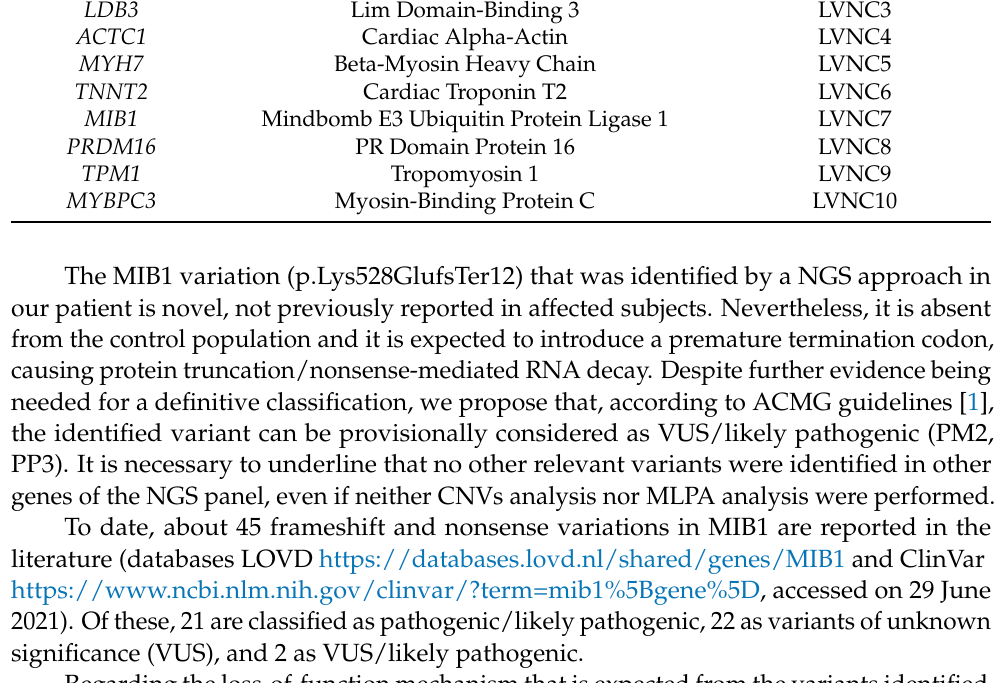
Table 1. LVNC genes according to current OMIM classification. Sarcomeric genes account for about 20–29% of LVNC, of which MYH7 and MYBPC3 represent the 12–13% and 2–8%, respectively [9,10]. Gene Protein DTNA _ _ LDB3 Lim Domain-Binding 3 ACTC1 TNNT2 PRDM16 TPM1